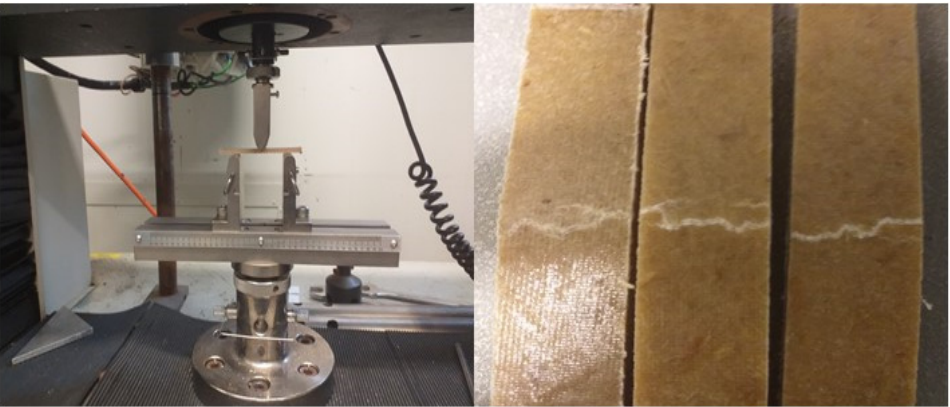
Figure 10. Sample picture of flexural testing samples (composite samples with 30 wt% fibre content) showing the cracks formed from the tensile sides.